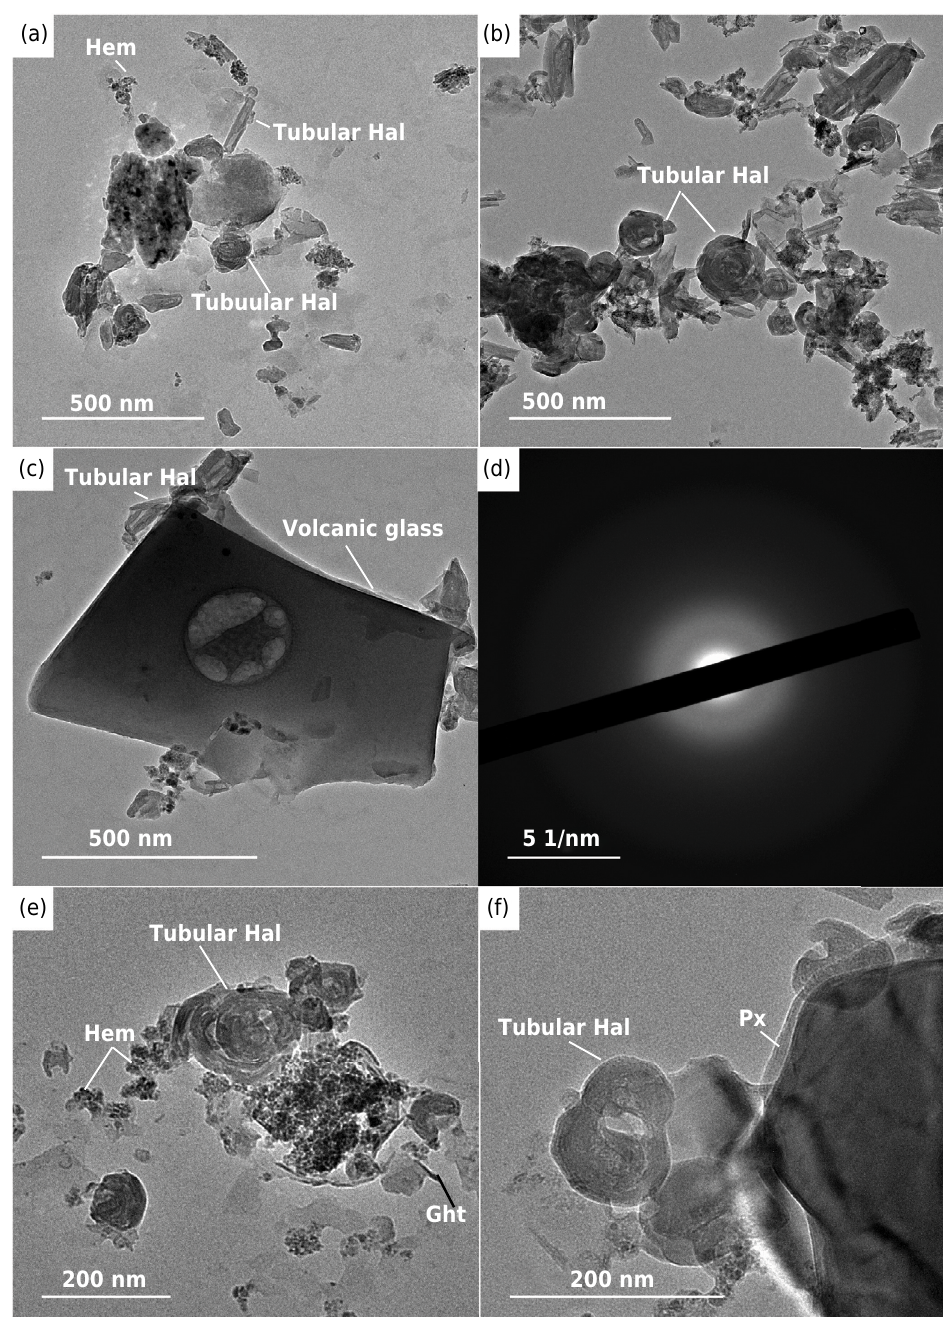
Figure 7. Transmission Electron Microscope images of fraction clay of P1. Tubular halloysite and iron oxides (hematite) in pyroclast (a). Tubular halloysite in C2 horizon (b). It is noted that the halloysite are very crystallized. Volcanic glass and halloysite in C2 horizon (c). Microdiffraction with a characteristic of amorphous material (d). Tubular halloysite iron oxyhydroxides (globular hematite and acicular goethite) in Bi horizon (e). Tubular halloysite near to the crystal pyroxene in A horizon (f). Hal: halloysite; Hem: hematite; Ght: goethite; Px: